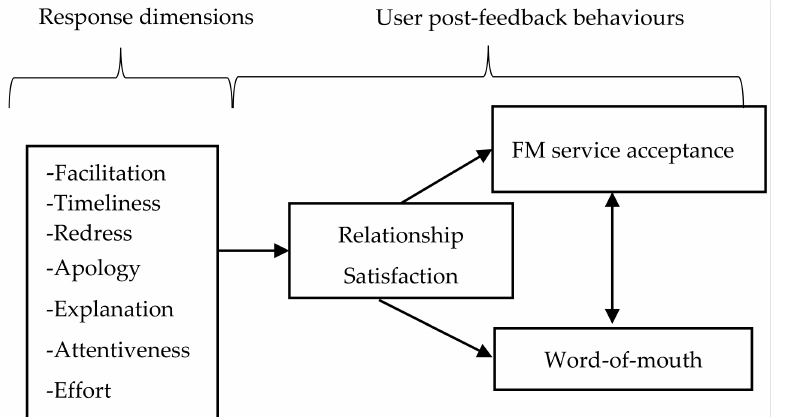
Figure 2. Hypothetical framework for facility managers responses to user post-occupancy feedback and behaviour. Adapted from Abisuga et al.